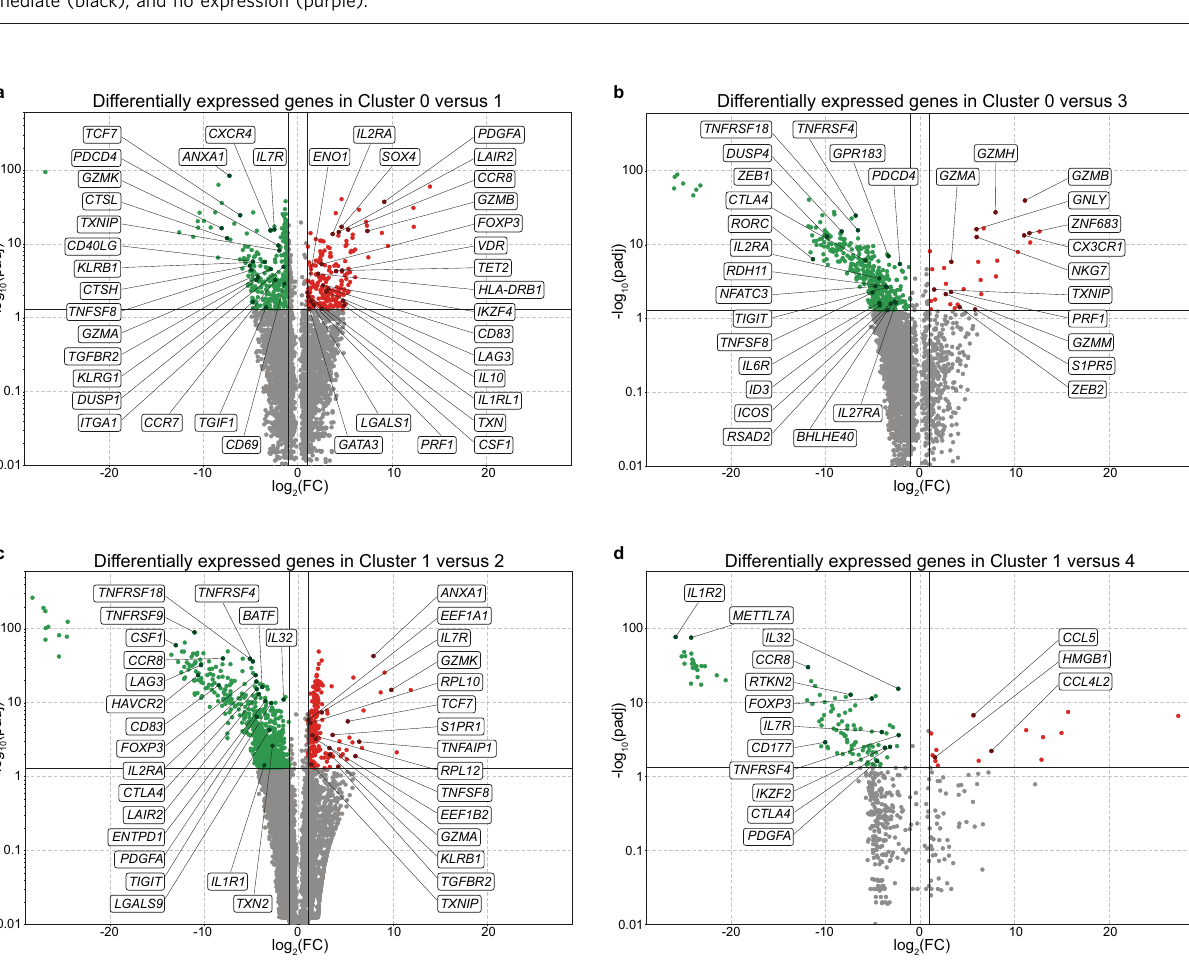
Fig. 3 Single-cell transcriptome analysis of circulating TA-reactive and tumor-in fi ltrating CD4 + TC in breast cancer patients. a Separation of tumor- in fi ltrating live CD4 + TC into CD25 + CD127 − (Q1, red) Treg, CD25 − CD127 + / − (Q3 and Q4, green) Tconv, and CD25 + CD127 + (Q2, orange) ActTconv using FACS sorting. b , c Venn diagram showing the number of common (white) TCR αβ clones (unique paired TCR αβ nucleotide sequences) between ( b ) blood-derived MAMI-IFN γ + Teff and tumor tissue (TT) in fi ltrating Tconv or ( c ) between tumor-in fi ltrating Tconv, Treg and ActTconv per breast cancer patient with mammary gland adenocarcinoma (MaCa). N , total number of TCR αβ clones per subset. Representative examples from two out of ( b ) n = 3, ( c ) n = 4 biologically independent replicates. d , e t-SNE representation of tumor-in fi ltrating CD4 + TC colored by ( d ) cell-surface phenotype (TT Tconv, dark green; TT Treg, dark red; TT ActTconv, dark blue) or ( e ) transcriptome cluster (0: early activated Tconv, red; 1: suppressive Treg, orange; 2: uncommitted Teff, green; 3: Th1 Teff, blue; 4: Pro-tumorigenic Treg, purple) from n = 4 MaCa patients. n refers to biologically independent replicates. f Heatmap of the top genes differentially expressed (DE) between transcriptome clusters among tumor-in fi ltrating CD4 + TC with high (yellow), intermediate (black), and no expression (purple).